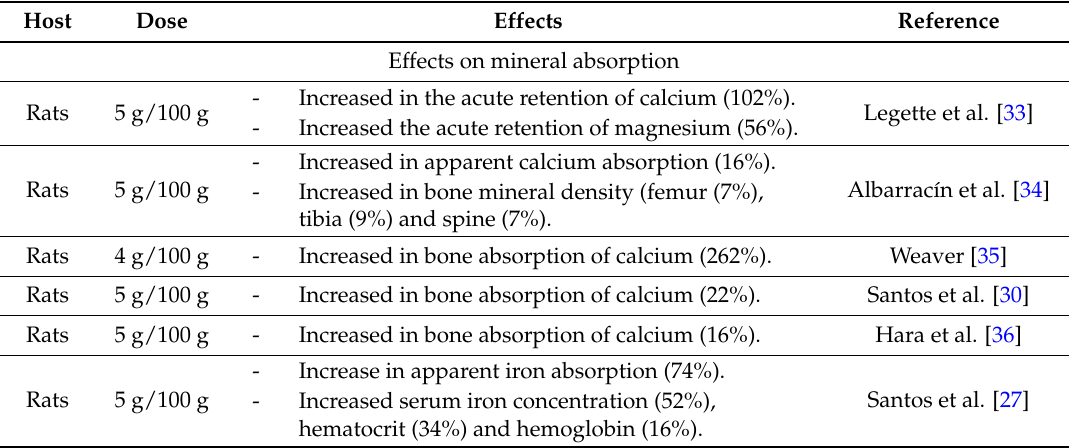
Table 1. The effects of administration of polydextrose on mineral